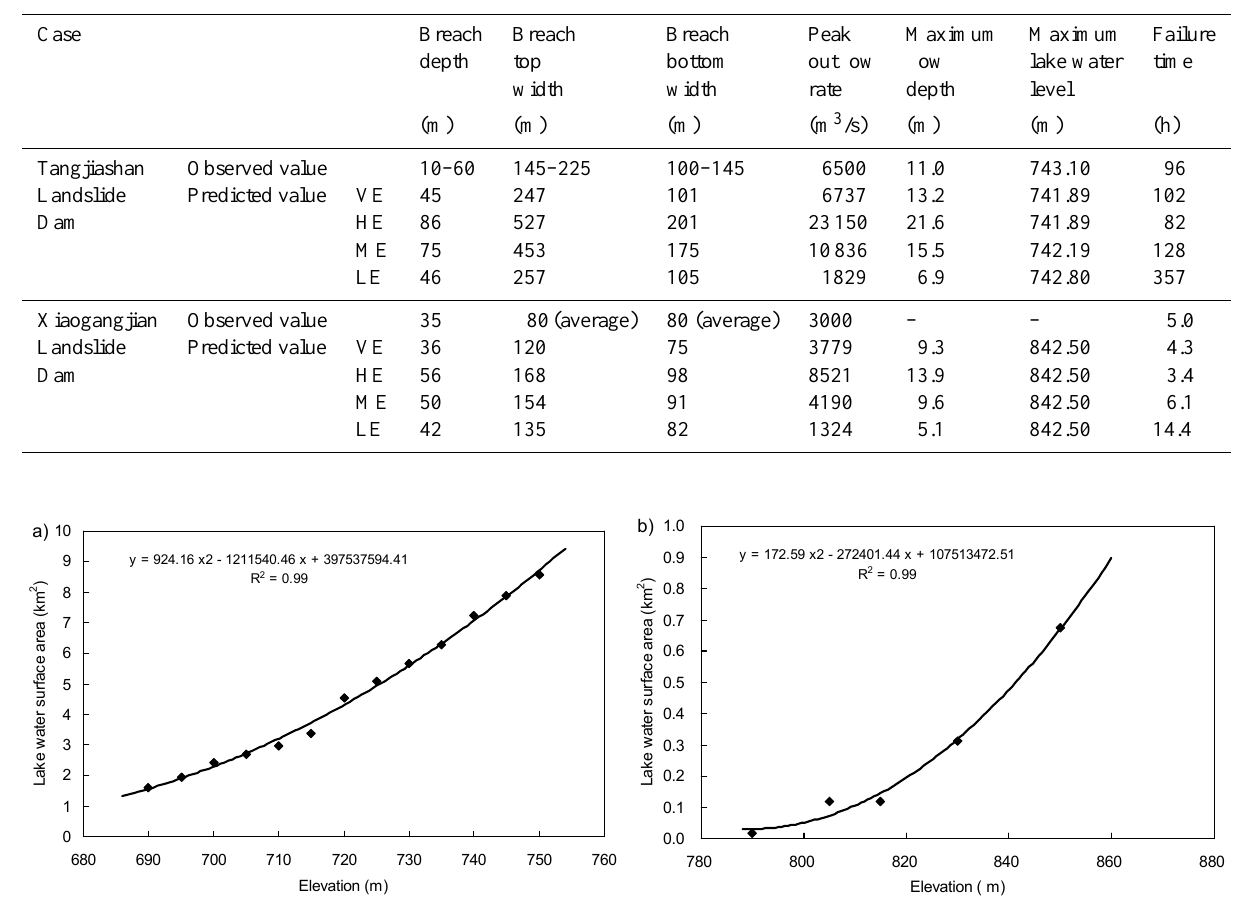
Table 2. Prediction of key breaching parameters for Tangjiashan Landslide Dam and Xiaogangjian Landslide Dam (failure time includes breach initiation time, breach formation time, and breach growth time). VE: varied erodibility; HE: high erodibility; ME: medium erodibility; LE: low erodibility.